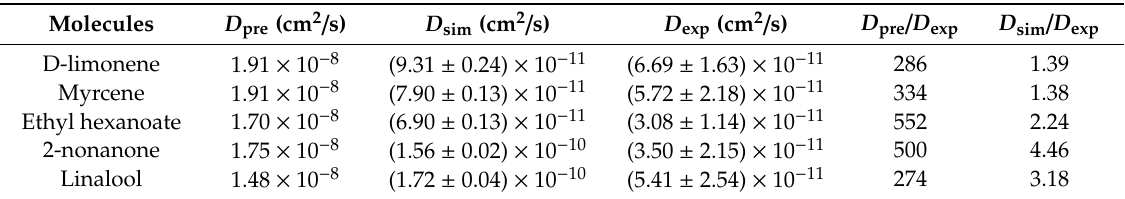
Table 5. Comparison between experimental, prediction model and MD simulation